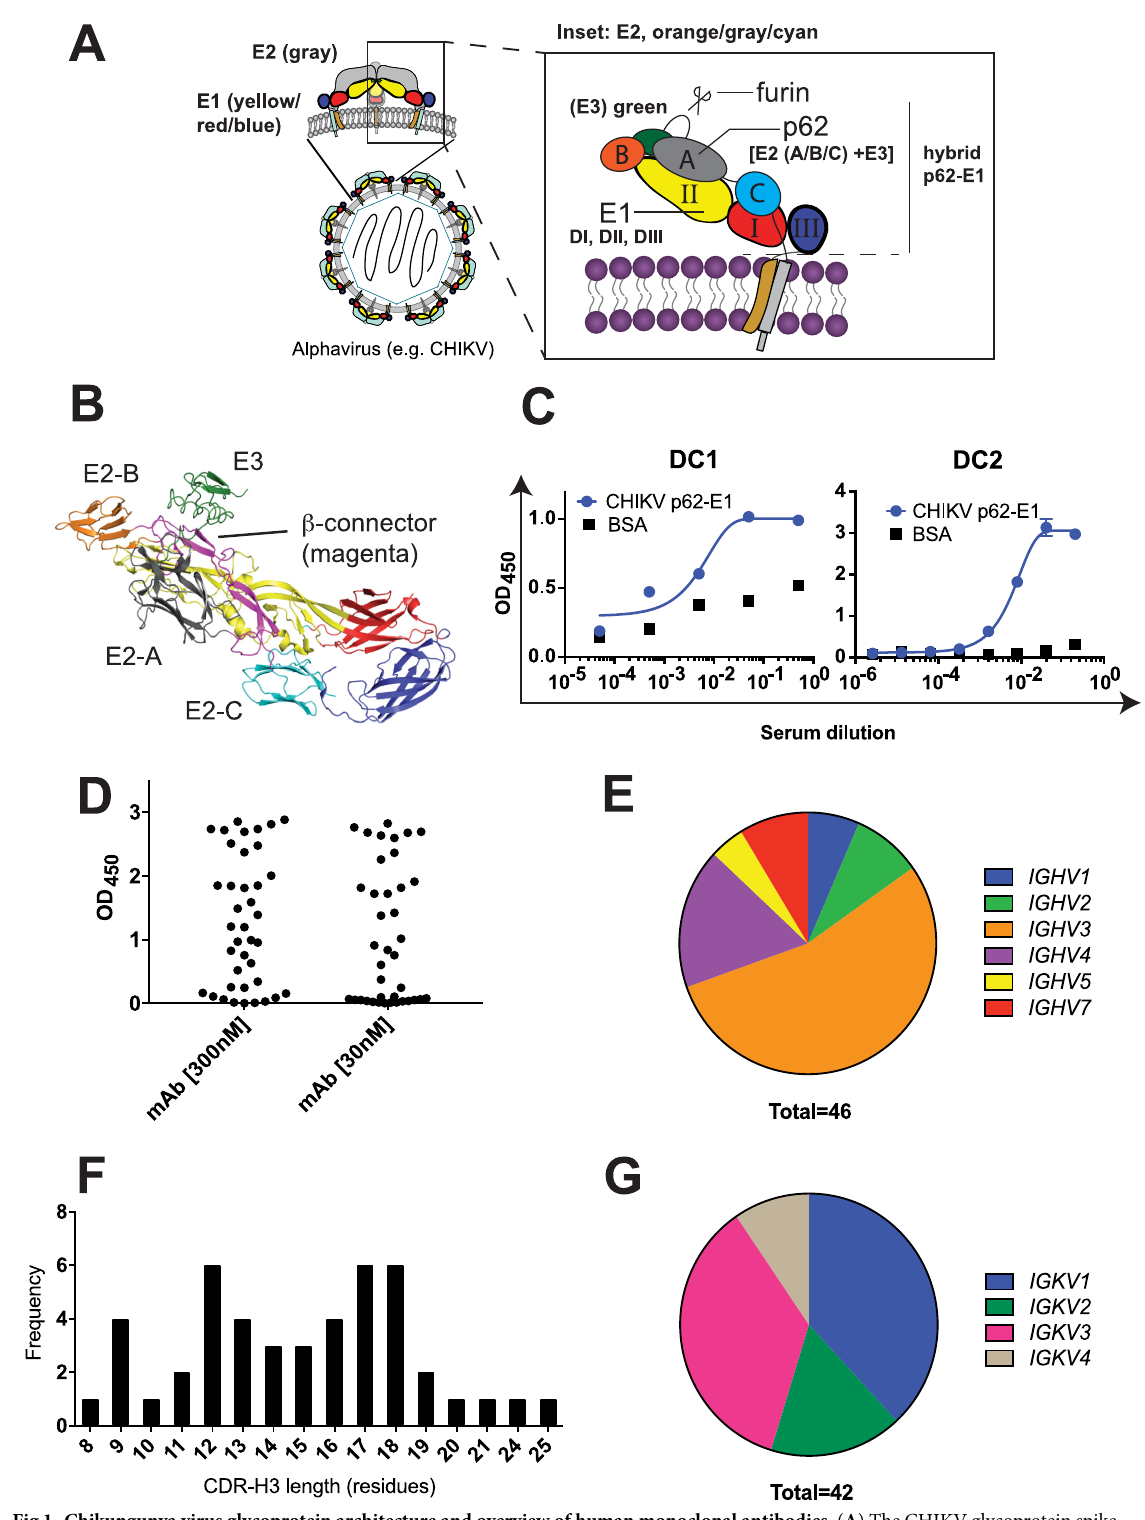
Fig 1. Chikungunya virus glycoprotein architecture and overview of human monoclonal antibodies. ( A ) The CHIKV glycoprotein spike consists of three copies each of E1 and E2 each in the prefusion form (modified from [8]). The inset shows the arrangement of E1 (comprised of DI, DII, and DIII) and E2 (comprised of domains A, B, and C). The location of E3 and the furin cleavage site also are shown. The hybrid protein “p62-E1”, consisting of p62 ectodomain linked to the E1 ectodomain by a polypeptide linker, was used for binding and sorting